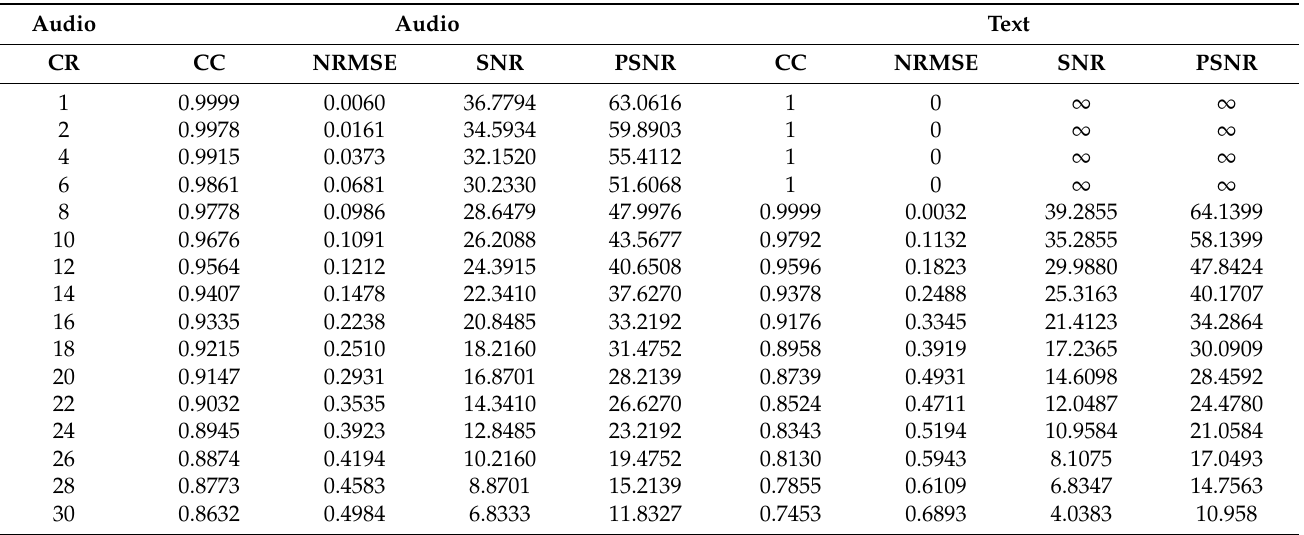
Table 1. The efficiency indicators of the stego-system based on the wavelet transform before the implementation of the developed